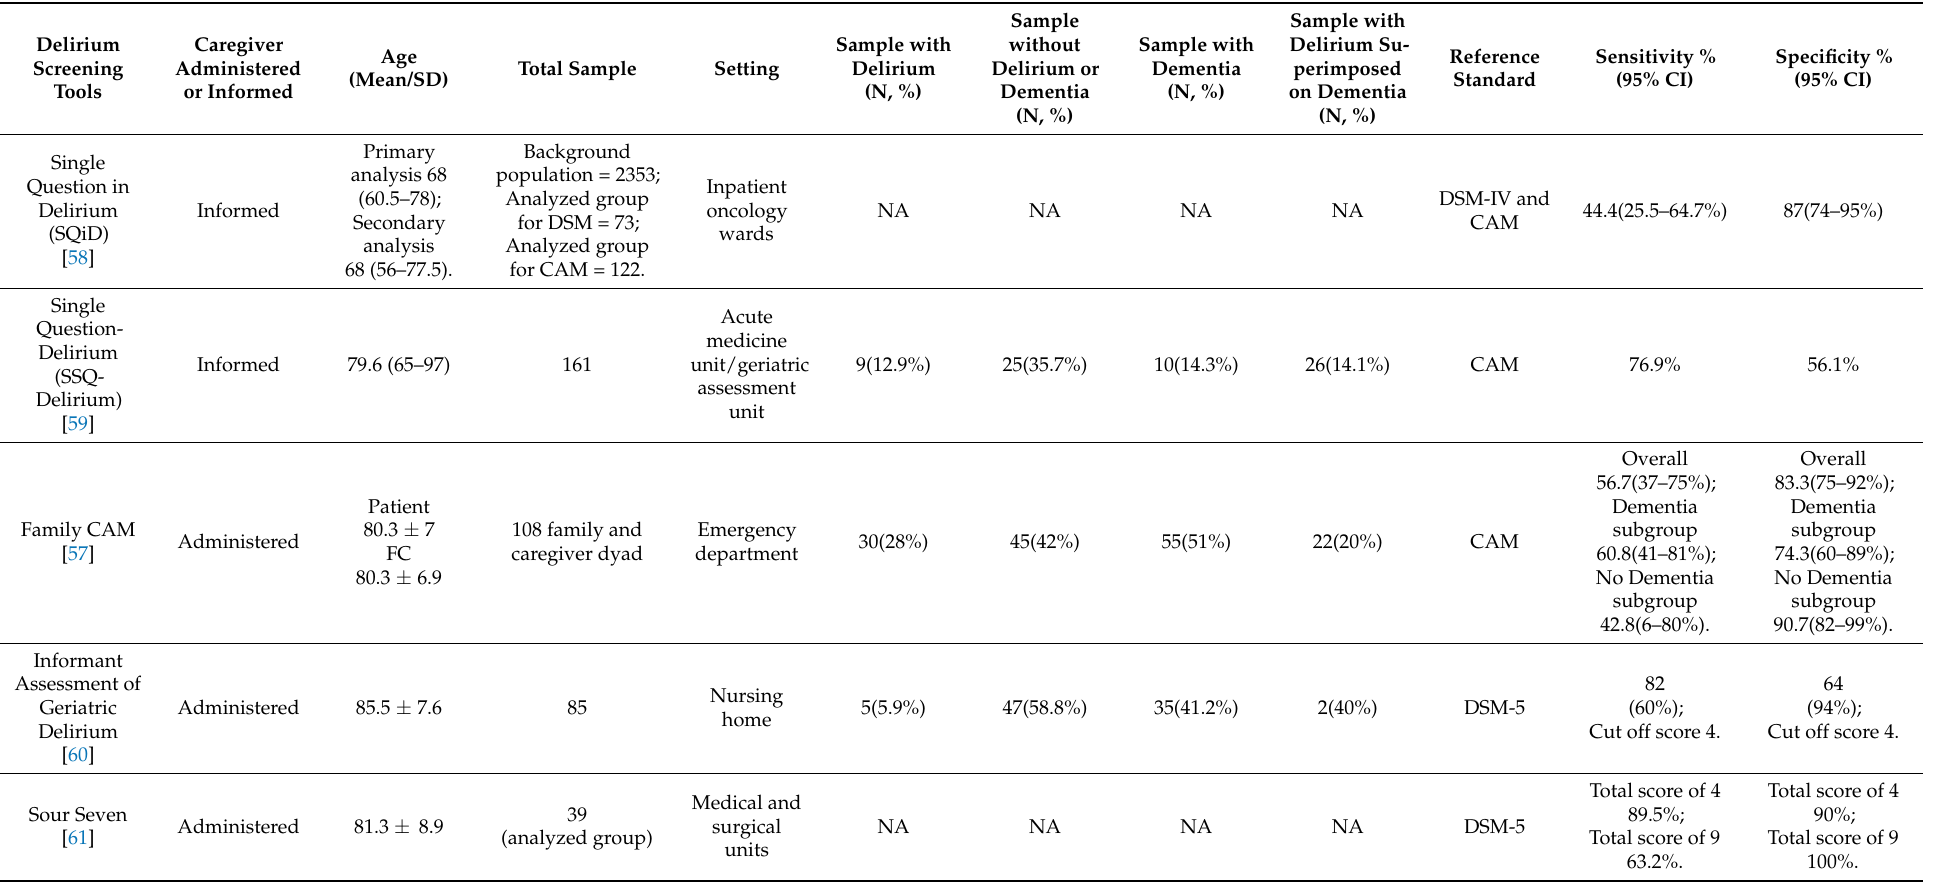
Table 2. Family care partner delirium/delirium superimposed on dementia detection